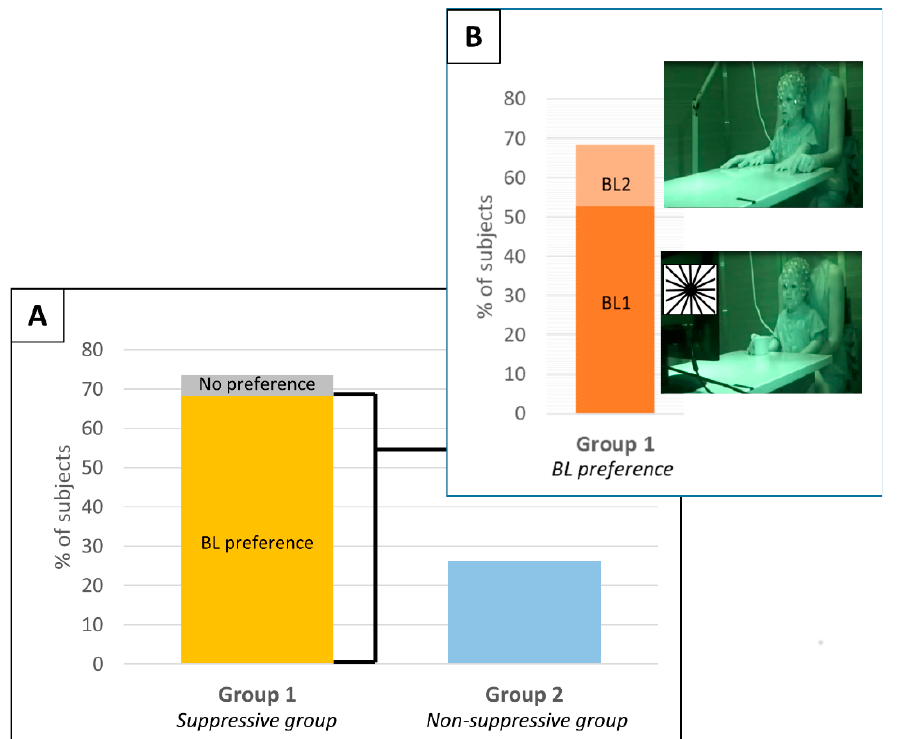
Figure 3. ( Panel A ) shows the percentage of subjects in the two identified groups: Group 1, suppressive group , and Group 2, Non-suppressive group . The subjects of Group 1 are divided between the ones that showed a baseline preference (yellow) and the ones that did not have a baseline preference (gray). (Panel B ) showed, among the subjects of group 1 that had a baseline preference, the ones that preferred BL1 (dark orange) and the ones that preferred BL2 (light orange).